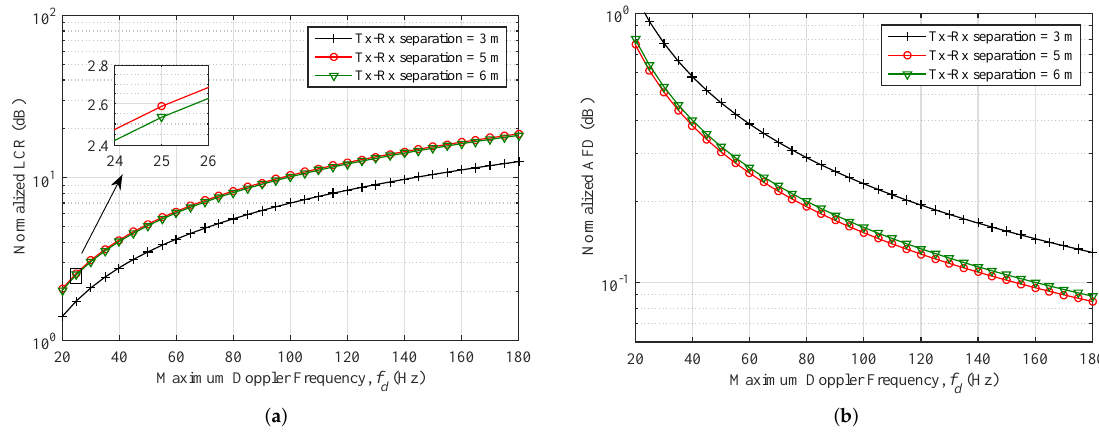
Figure 6. LCR and AFD plotted against different values of maximum Doppler shift in ( a , b ), respectively; for different scenarios of indoor mmWave (Case 2 (a); 28 GHz) radio propagation environments. ( m = 1, ρ =